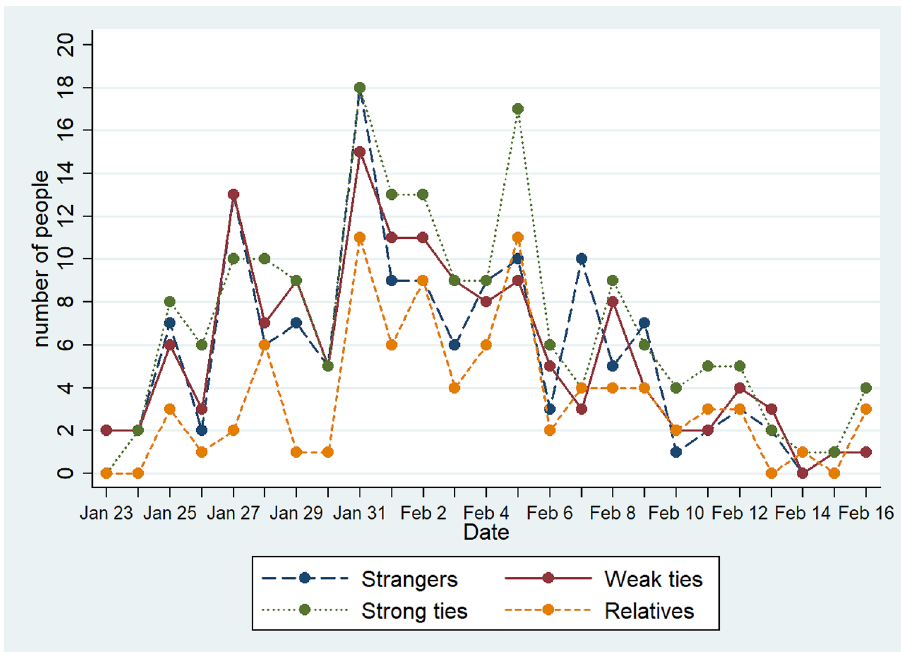
Figure 4. Social network infection route of patients with COVID-19 in Shaanxi Province. Strangers refer to how many of the cases announced that day may have been infected by strangers. Weak ties indicate how many people may be infected by weak tie contacts. Strong ties refer to how many people may be infected by strong tie contacts. Relatives refer to whether any of the patient’s relatives are